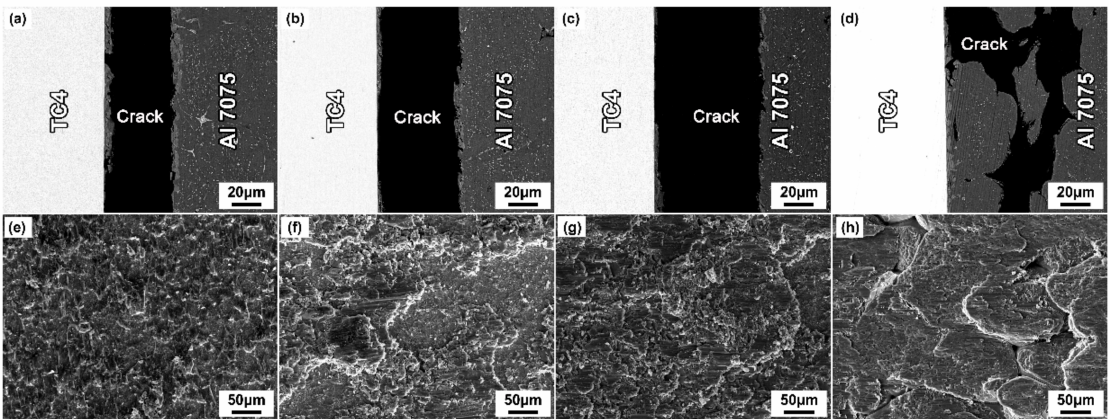
Figure 8. Fracture morphologies of TC4/Cu layer/Al7075 joints brazed at different temperatures for 30 min. ( a,e ) 560 ◦ C; ( b , f ) 580 ◦ C; ( c , g ) 600 ◦ C; ( d , h ) 620 ◦